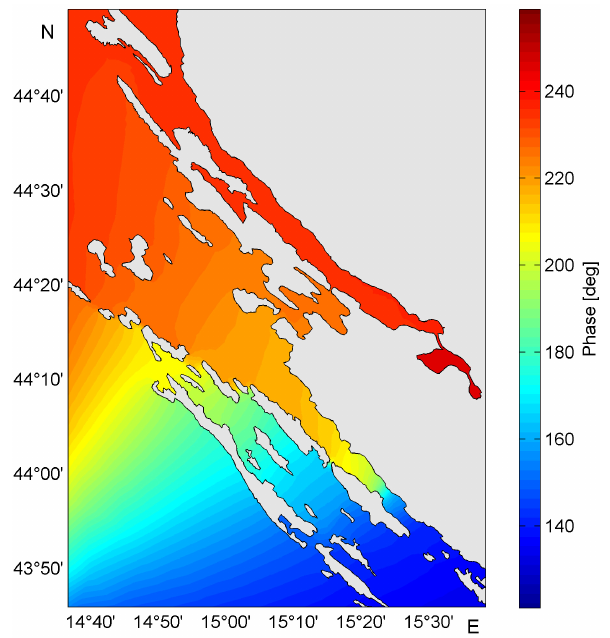
Fig. 8. Co-phase chart for M2 tidal constituent, zoomed on a part of the eastern Adriatic.